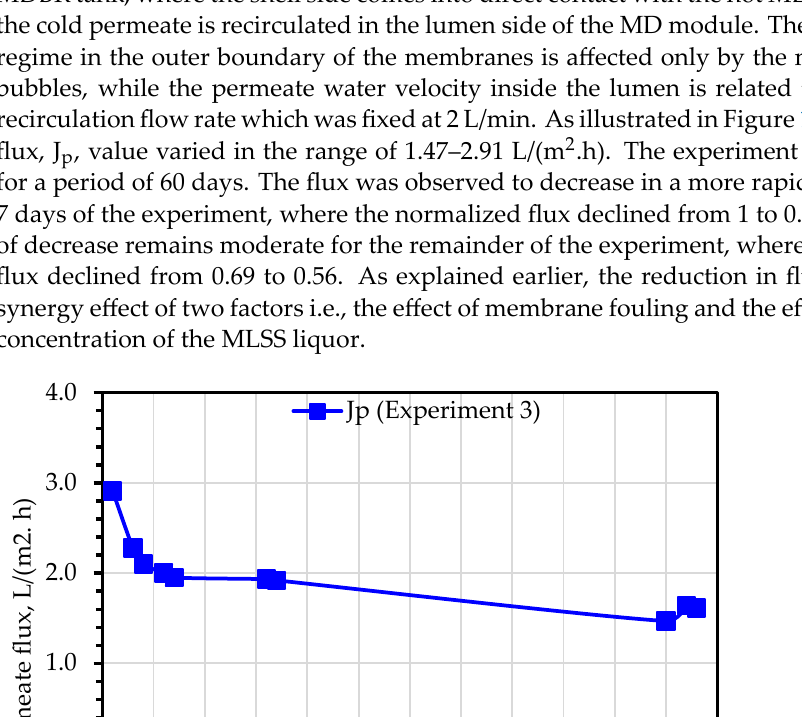
Figure 11. Variations of TDS values observed during the treatment of secondary wastewater using a hybrid DCMD system (Experiment 3).